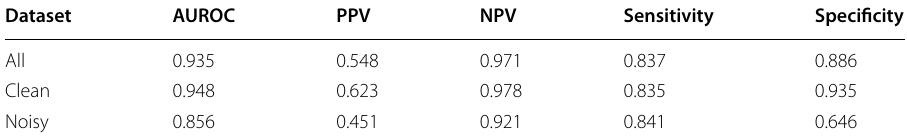
Table 2 Metrics for AF (test positive) versus sinus rhythm (test negative) classification on the KGH dataset. Results are shown for both the combined class samples and separately for clean and noisy subsets